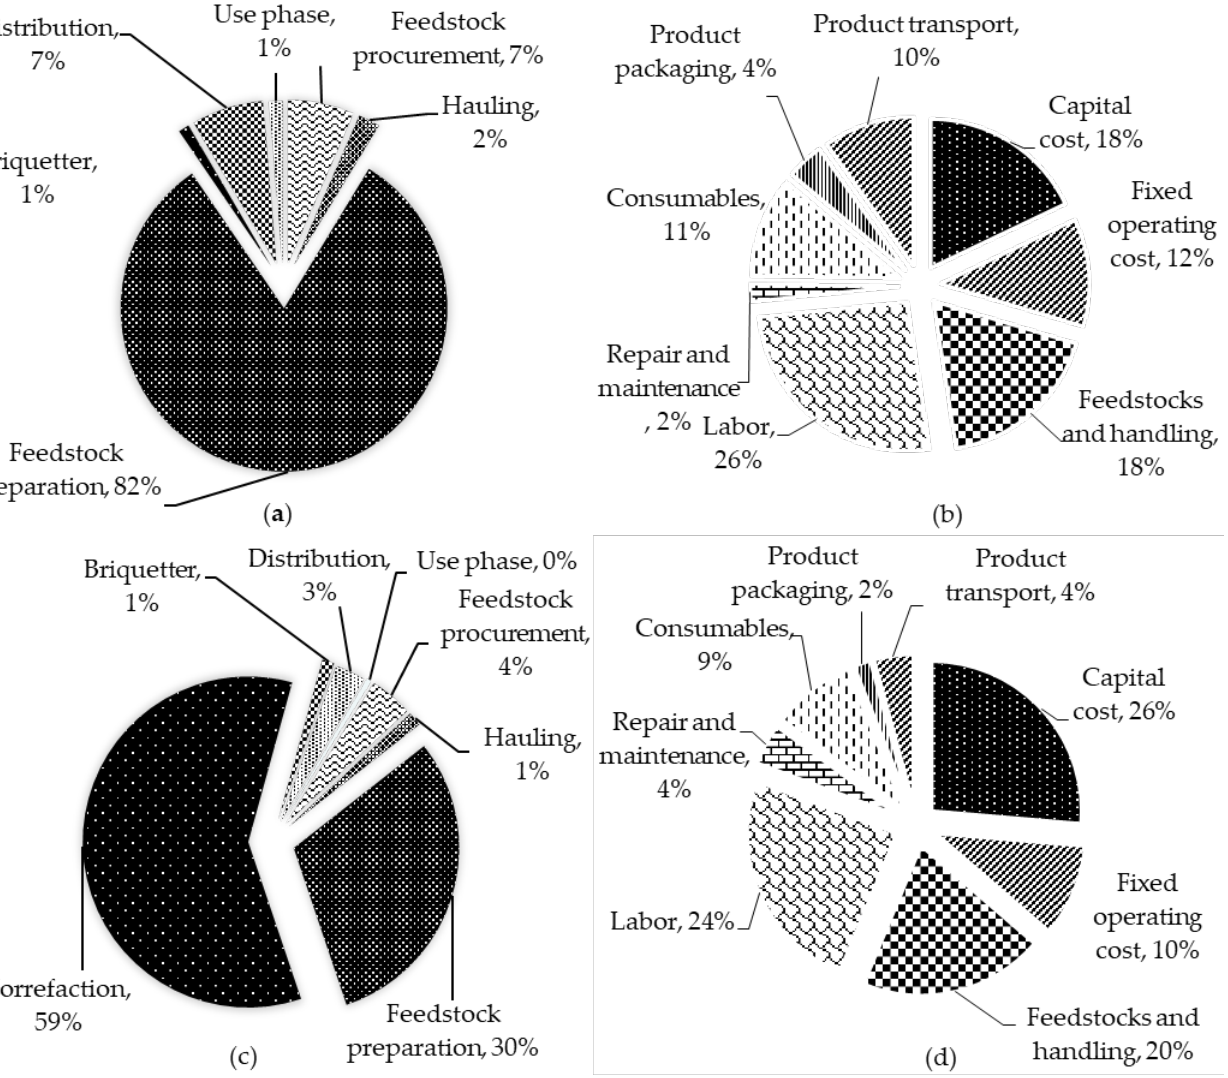
Figure 4. Contribution of various unit processes or inputs to the ( a ) overall global warming impact, and ( b ) cost of 1 MJ of useful heat produced from wood briquette; ( c ) overall global warming impact, and ( d ) cost of 1 MJ of useful heat produced from torrefied wood